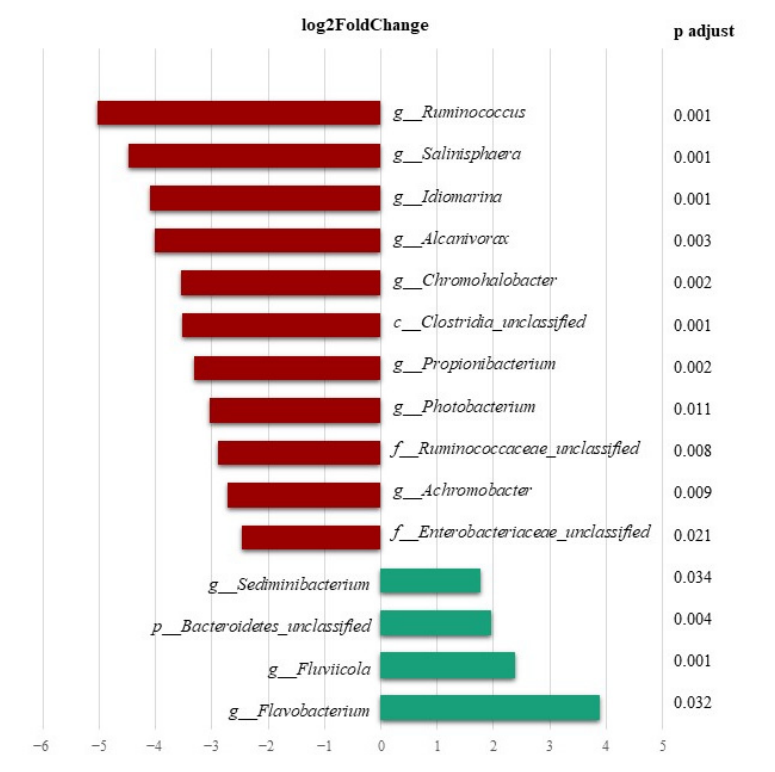
Figure 5. Significant differences of DESeq2 at the genus level with abundance relative > 0.5% (DESeq2, p < 0.05) in the mucus microbiota of the skin. Comparison between the wounded groups of fish that received the control diet (CW) and probiotic (PW).